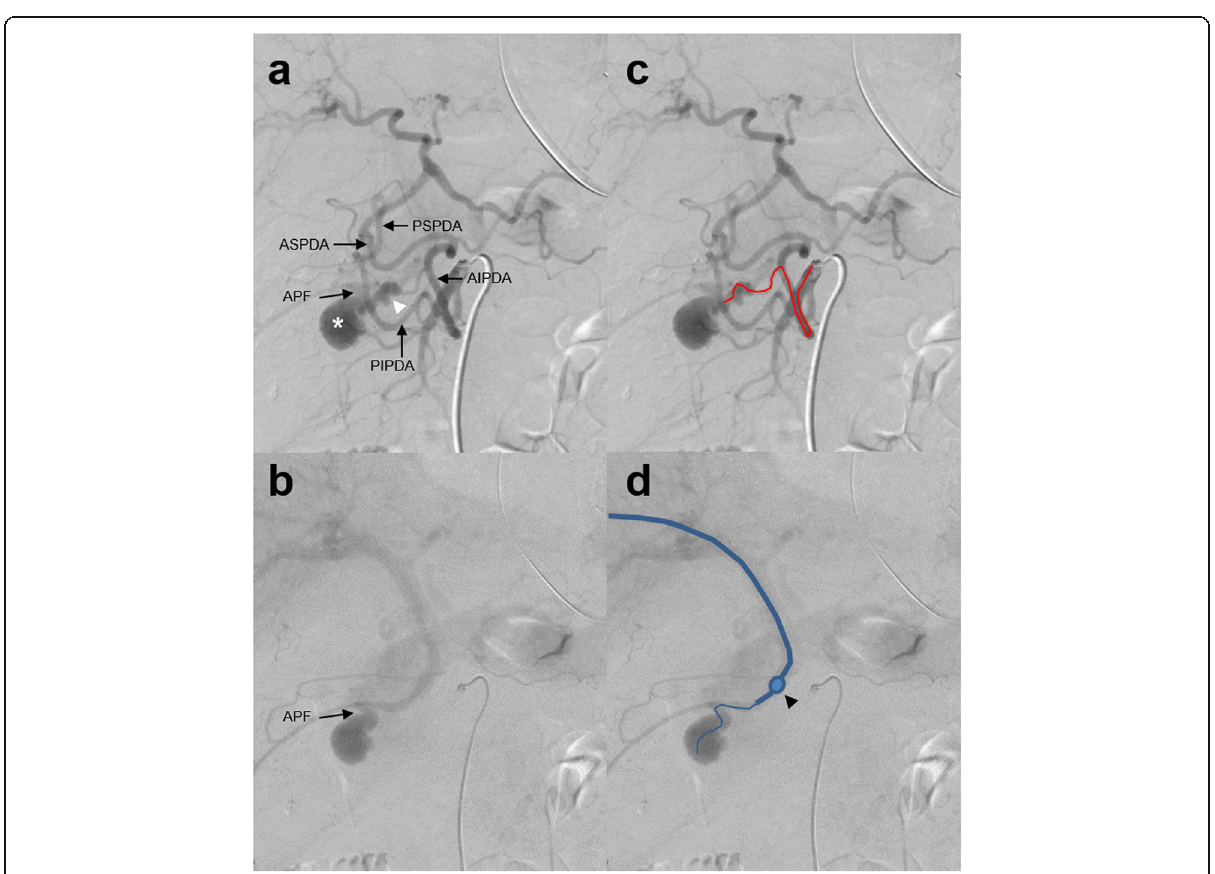
Fig. 2 Emergency angiography findings: left-anterior oblique 20-degree images of superior mesenteric arteriography. a The hepatic and splenic arteries were viewed via the pancreaticoduodenal arcade, and the routes from the anterior and posterior inferior pancreaticoduodenal arteries (AIPDA and PIPDA) to the anterior and posterior superior pancreaticoduodenal arteries (ASPDA and PSPDA) were observed. No extravasation was present. A pseudoaneurysm (white asterisk) was visualized via the branch of the AIPDA (white arrowhead). The arcade from the PIPDA to the PSPDA was not involved in the pseudoaneurysm. b The portal vein was subsequently visualized from the pseudoaneurysm through the arterioportal fistula (APF). c Same image as a). The trace of the microcatheter advanced via the AIPDA is shown by the red line. d Same image as b). A balloon catheter was advanced to the hepatic side of the APF using a percutaneous transhepatic portal approach, and the microcatheter was advanced through the balloon catheter to the pseudoaneurysm (blue line). The position of the balloon is indicated by a black